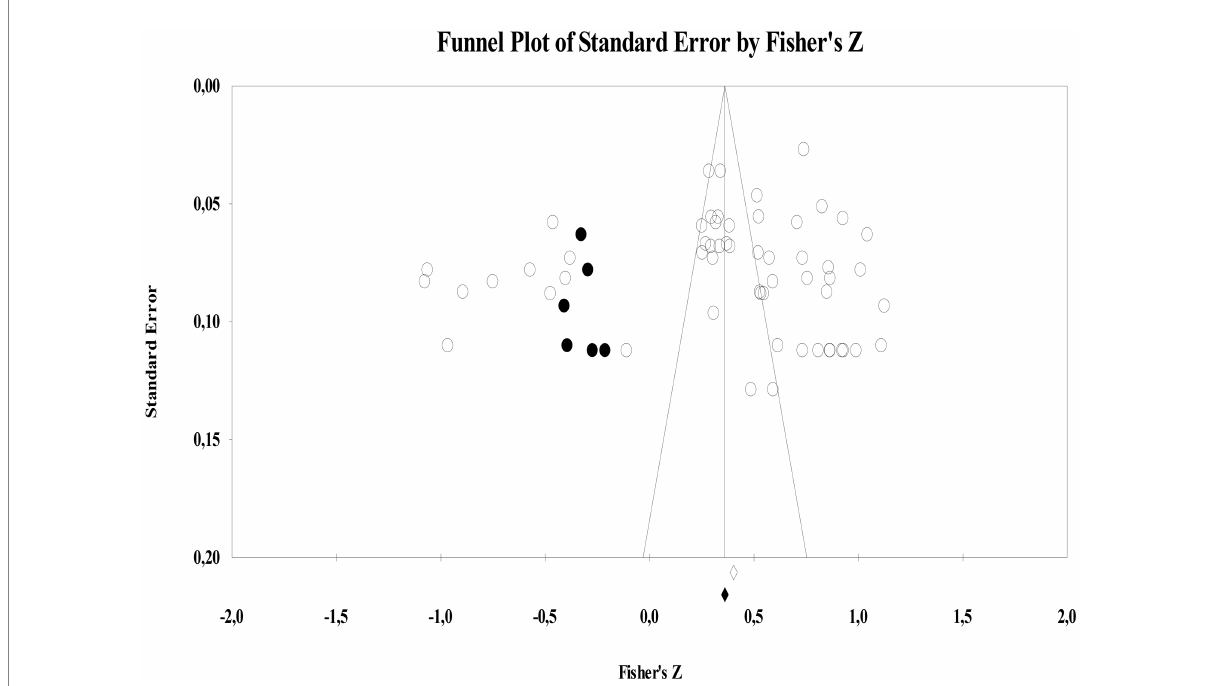
FIGURE 1 Funnel scatter plot illustrating relationship between leadership in HEIs and academic staff’s job satisfaction.